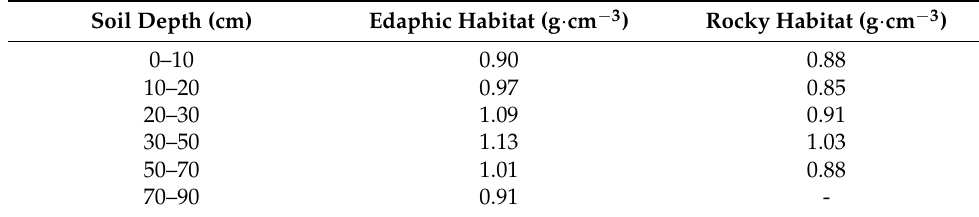
Table 1. The soil bulk density of two the